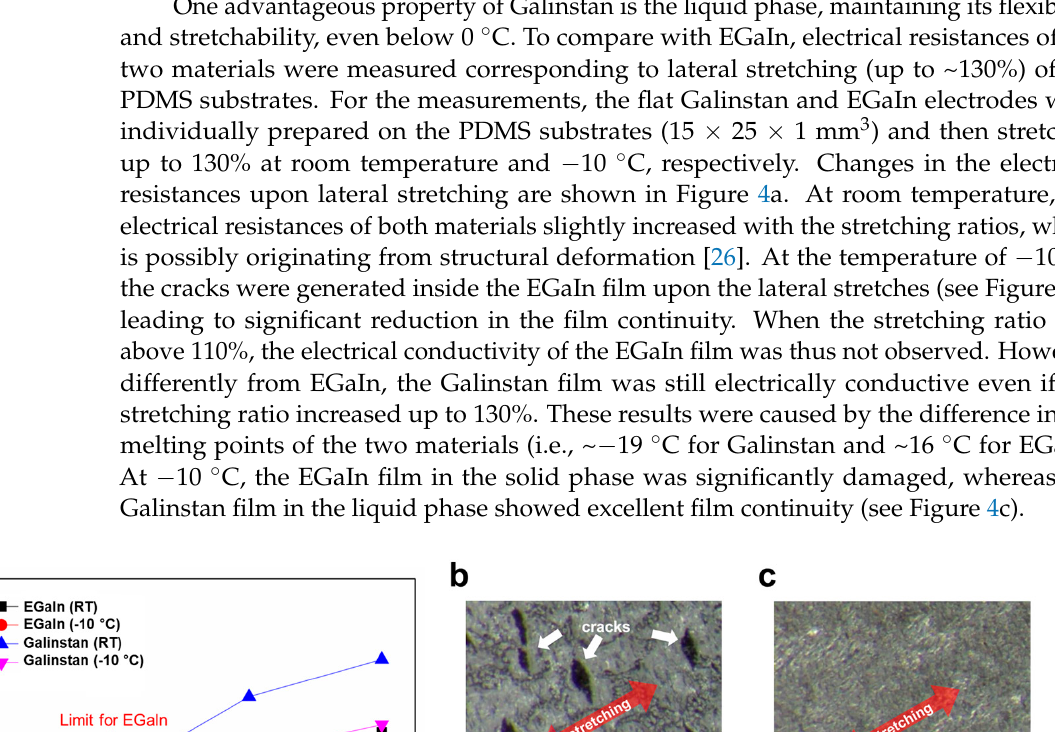
Figure 3. Electrical resistance and conductivity of a line-patterned Galinstan electrode (80 μ m × 5 mm) corresponding to the structural deformation of the PDMS substrate.